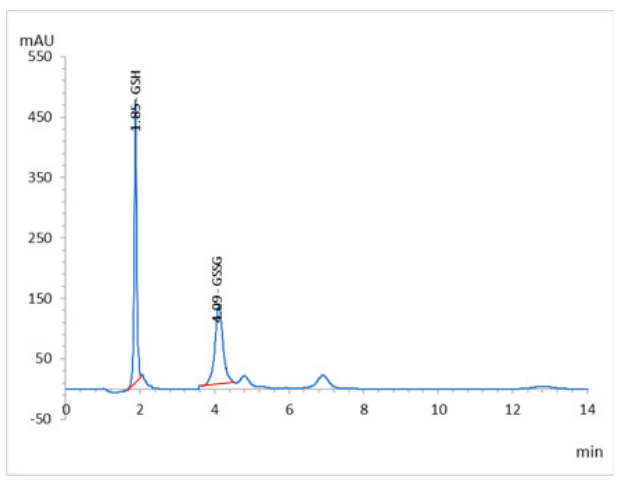
Figure 4. RP-HPLC chromatogram of the GSH and GSSG of working standard mixture (5.0 µgmL − 1 ) taken under optimized conditions.